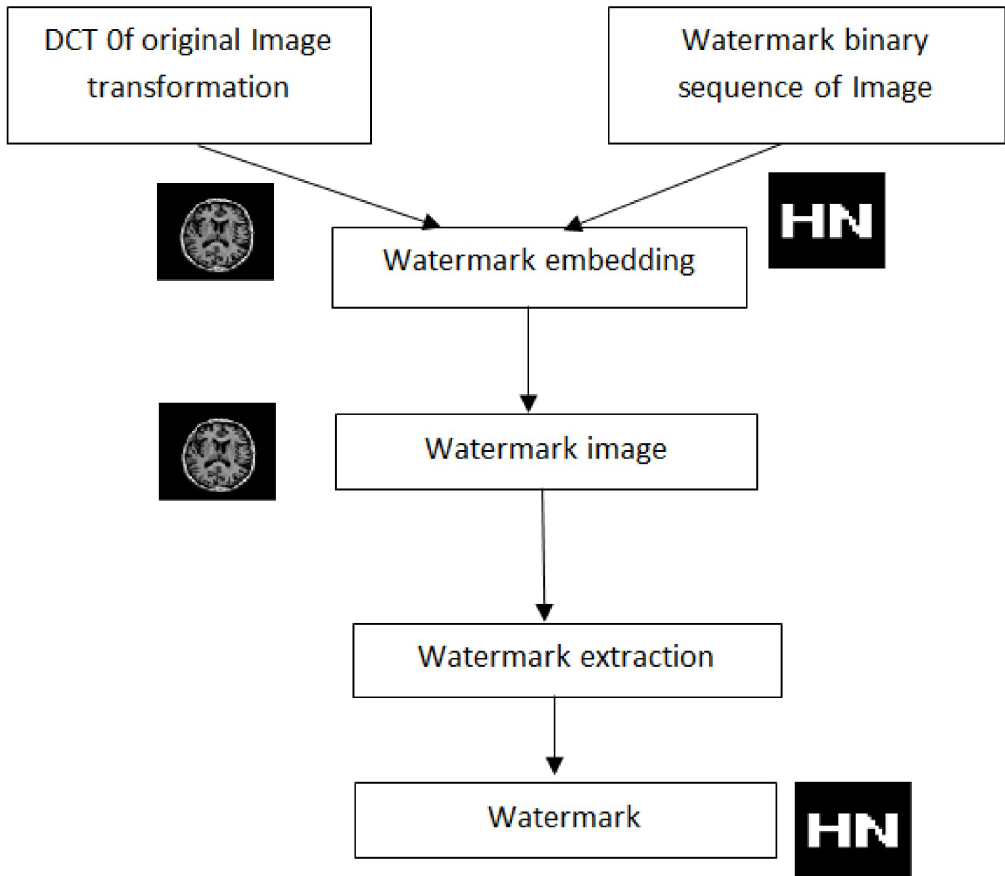
Fig 1. Watermarking steps using a DCT